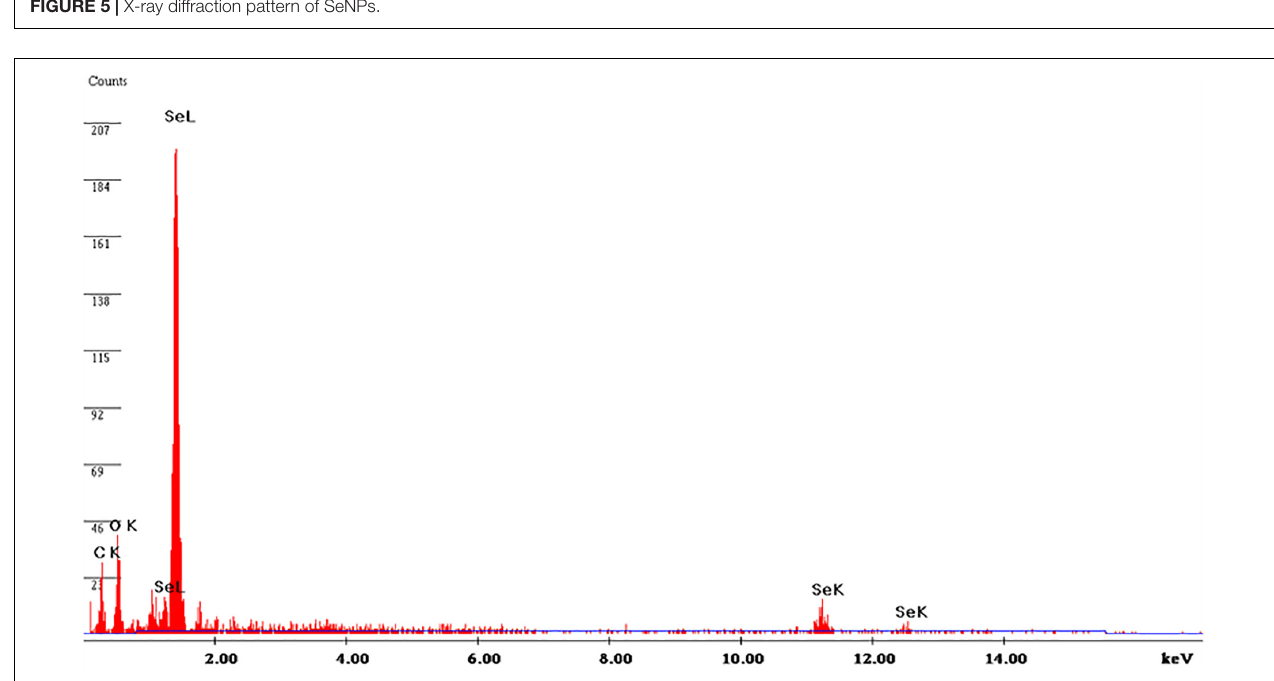
FIGURE 5 | X-ray diffraction pattern of SeNPs.